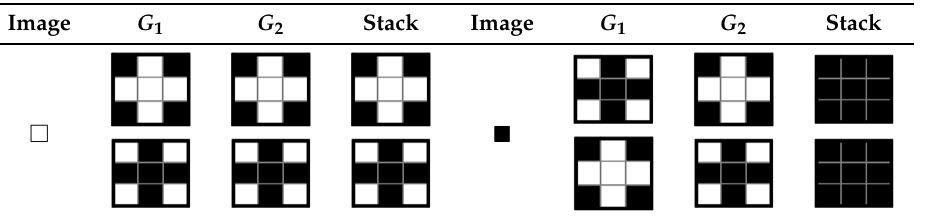
Table 3. The designed patterns for n = 3.